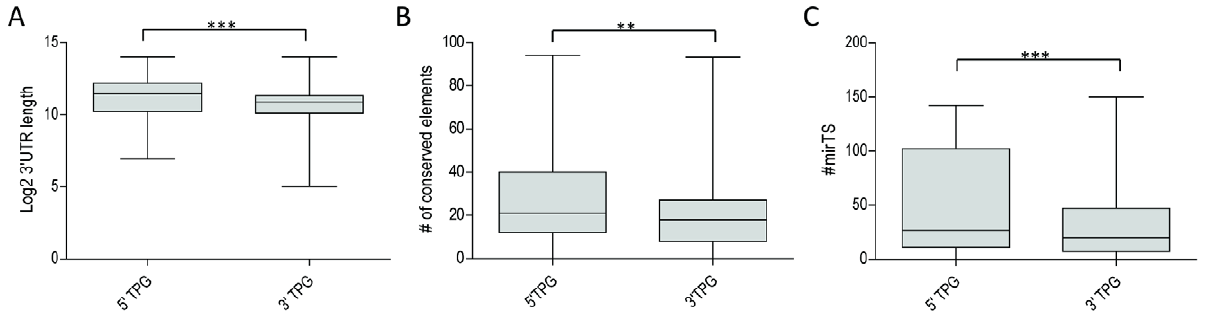
Figure 3. Characteristics of 3 9 UTRs of 5 9 and 3 9 TPGs. A : 3 9 UTR length. B : number of conserved elements (phastConsElements44way track, hg18 genome assembly from http://genome.ucsc.edu/. C: number of microRNA target sites (PITA Top Targets from http://ophid.utoronto.ca/mirDIP. ***, **: P , 0.0001, 0.001, Wilcoxon signed rank test.